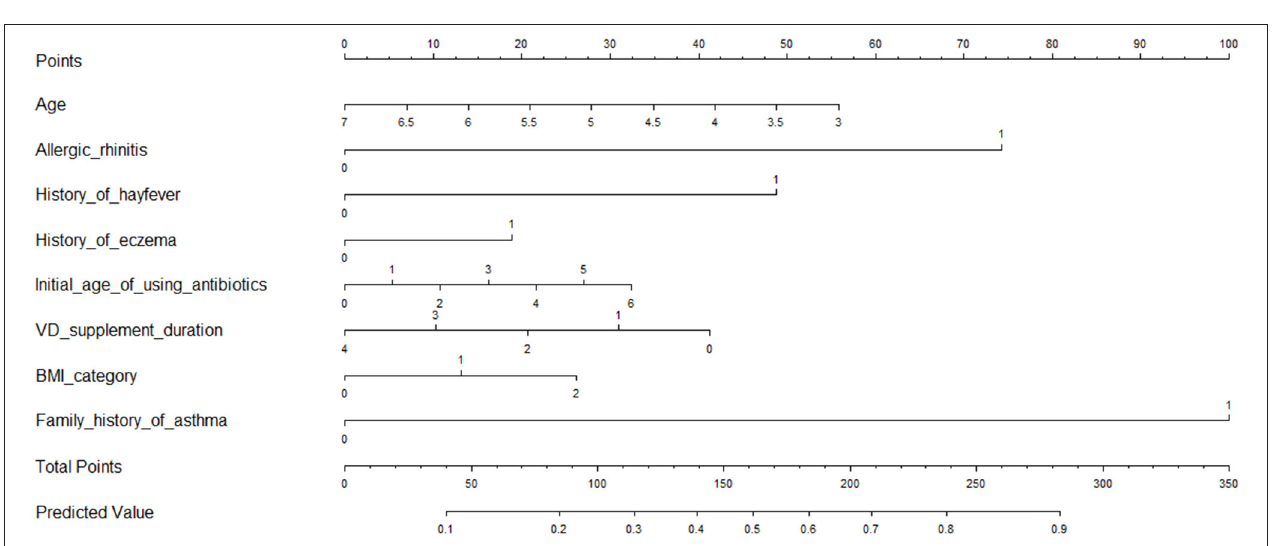
FIGURE 3 | Prediction nomogram for prediction in children with